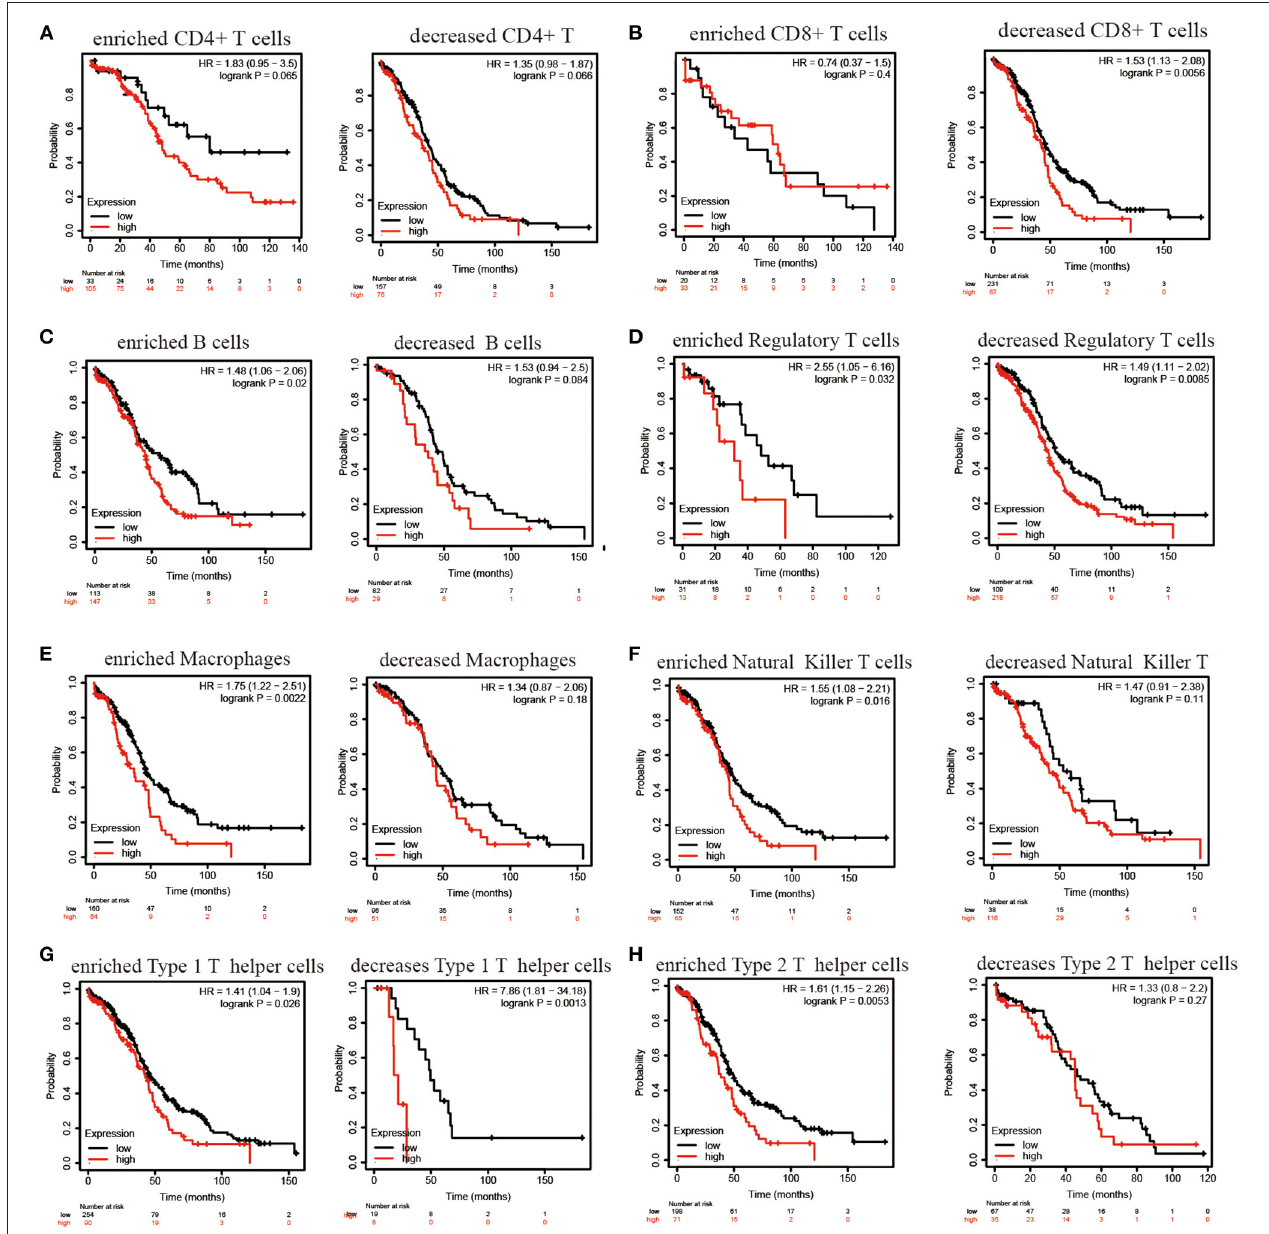
FIGURE 7 | Kaplan–Meier survival curves based on expression of PER1 related to immune cell subtypes in OV. (A–H) Correlations between PER1 and OS in OV patients in different immune cell subgroups as estimated by the CIBERSORT